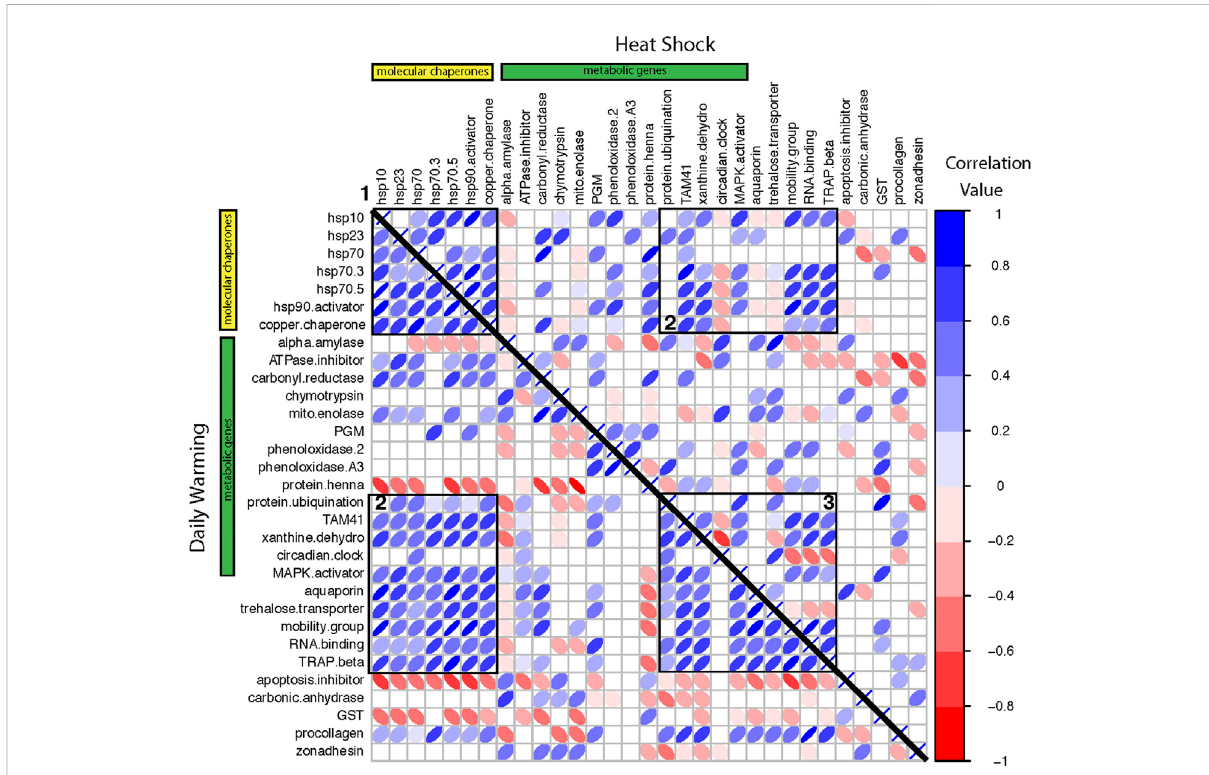
FIGURE 5 Correlation matrices of gene expression change ordered by functional category for the daily warming treatment on the lower triangle and the heatshocktreatmentontheuppertriangle.Theyellowbarindicatesmolecularchaperones.Thegreenbarindicatesmetabolicgenes.Theremaining genes have various functions (see Supplementary Table S2). Each row/column is one gene-by-gene comparison. The color and width of the ellipse indicate the correlation strength and direction. Blank cells represent non-signi fi cant correlations. Numbered boxes denote clusters of strong positive correlations described in the text.